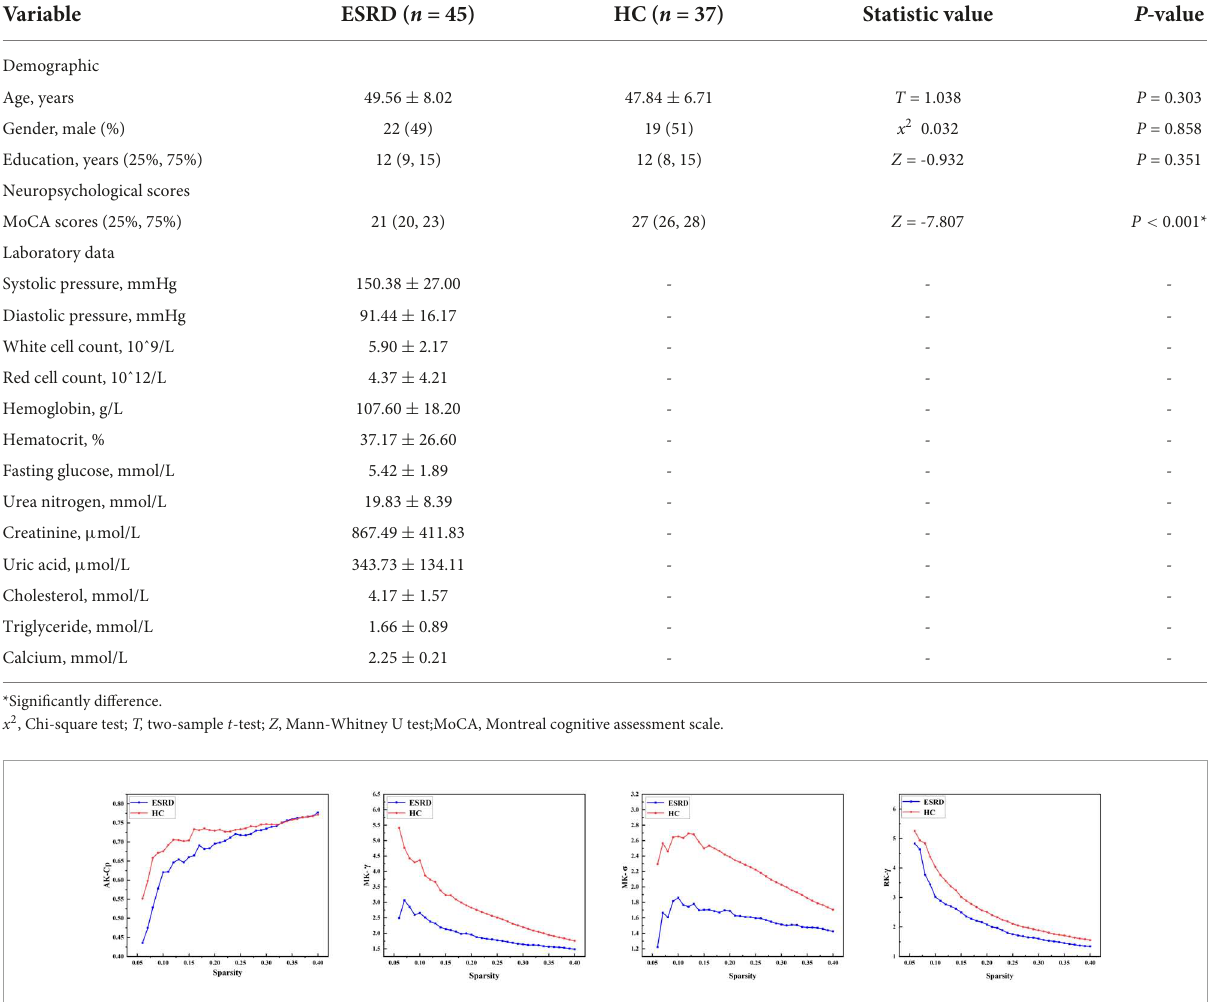
TABLE 1 Demographic and clinical characteristics and neuropsychological test scores.